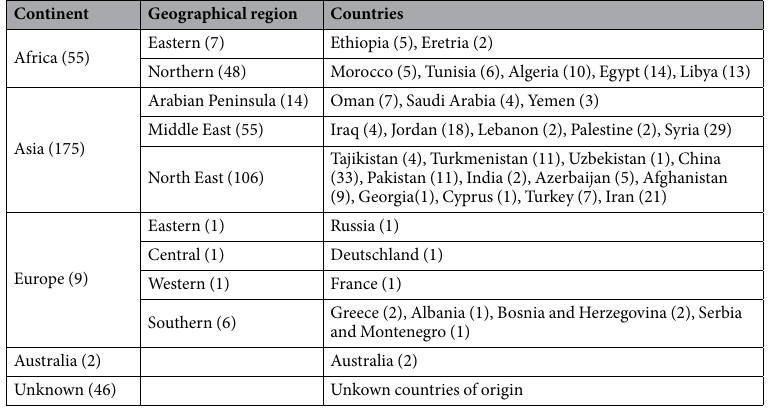
Table 6. The geographic origins of the barley accessions used in the study. Numbers in brackets indicate how many accessions from each